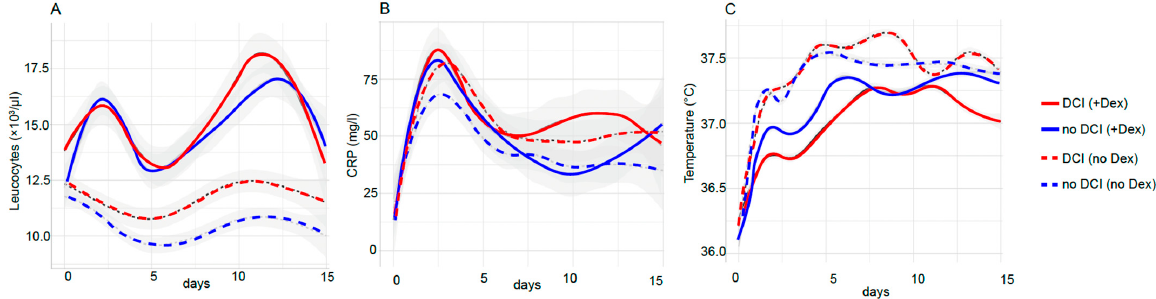
Figure 1. Data of the SAH patients after the first ICU admission was collected for 500 h (approxi ‐ mately 24 days). Depicted are the values of leukocytes ( A ) and C ‐ reactive protein ( B ) in peripheral blood (> 8500 values) and the temperature ( C ) (> 120,000 measurements using a bladder catheter). The patients who received dexamethasone during their admission to the intensive care unit were considered to belong to the dexamethasone group (continuous line). The SAH patients were further subdivided according to a cohort, which suffered delayed cerebral ischemia. The lines represent a generalized additive model and the confidence interval is in grey. DCI = delayed cerebral ischemia; Dex = dexamethasone; CRP = C ‐ reactive protein. Table 2. White blood cell counts and C ‐ reactive protein values at multiple timepoints.